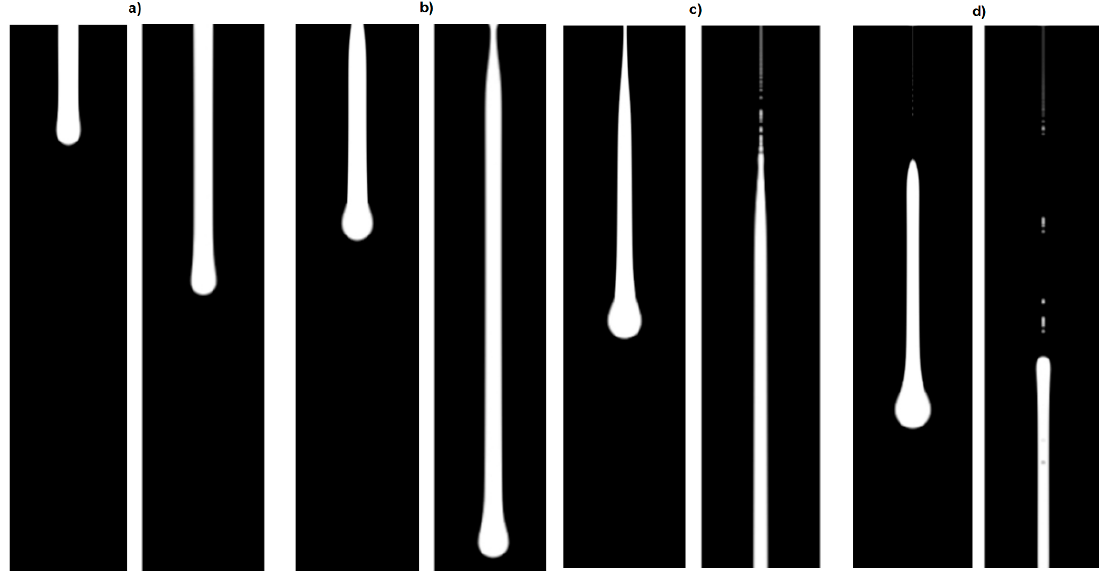
Figure 6. Comparison between different inlet velocities at the following four time steps: ( a ) 6 μ s, ( b ) 12 μ s, ( c ) 18 μ s, and ( d ) 24 μ s.